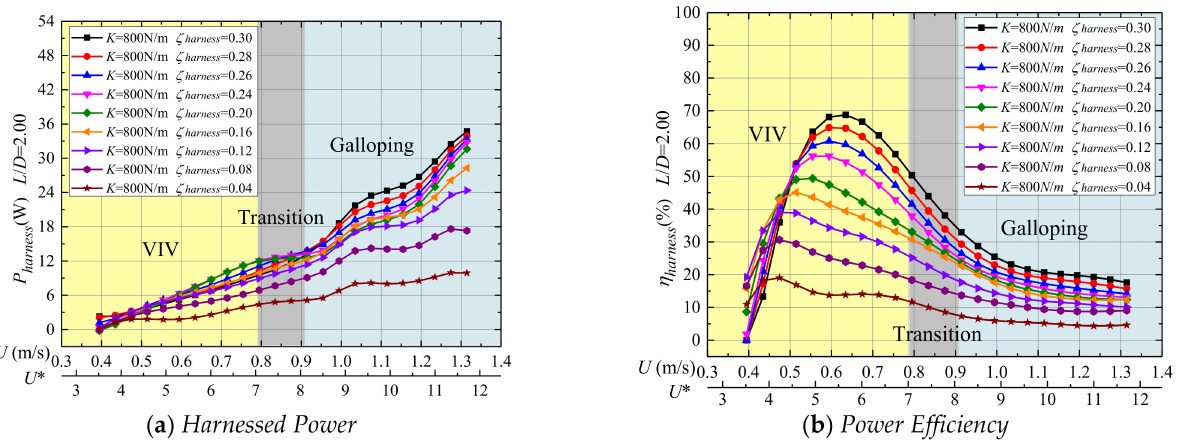
Figure 10. ( a ) Harnessed power and ( b ) power efficiency of two tandem cylinders with spacing ratio L / D = 2.00; K = 800 N/m; ζ harness = 0.04–0.30.